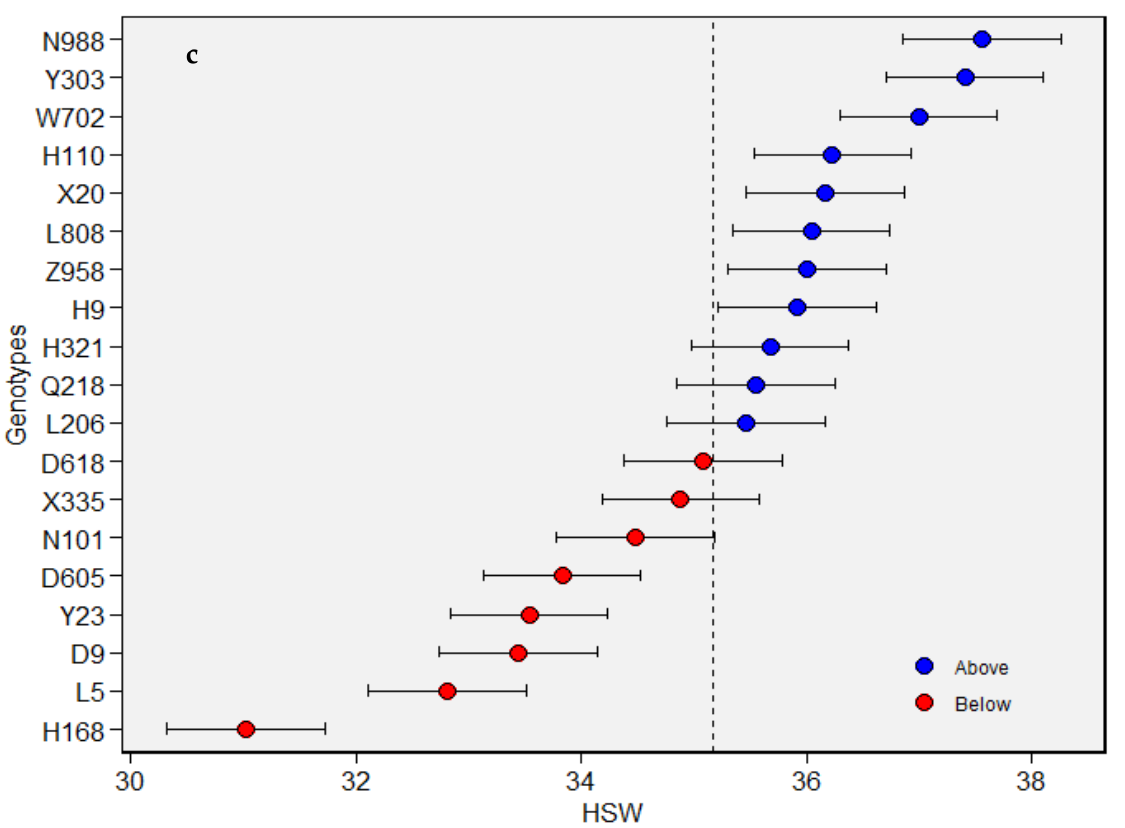
Figure 1. The predicted agronomic performance of 19 maize genotypes based on BLUP (best linear unbiased prediction). The blue and red circles represent higher and lower than the BLUP means, respectively. The horizontal error bars indicate the 95% confidence interval when considering the two-tailed t -test. ( a ) represent grain yield (GY); ( b ) represent ear length (EL); ( c ) represent hundred seed weight (HSW).